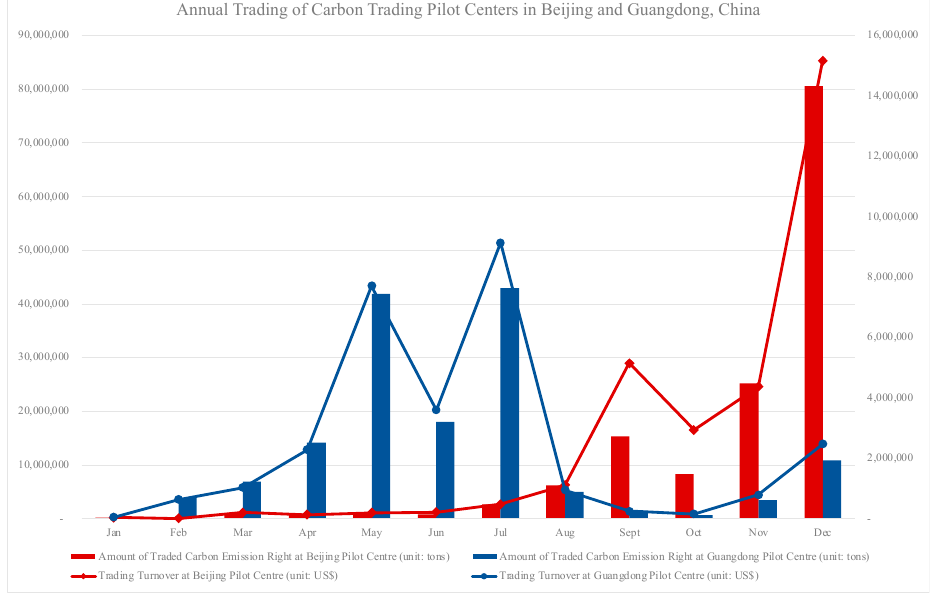
Annual Trading of Carbon Trading Pilot Centers in Beijing and Guangdong, China